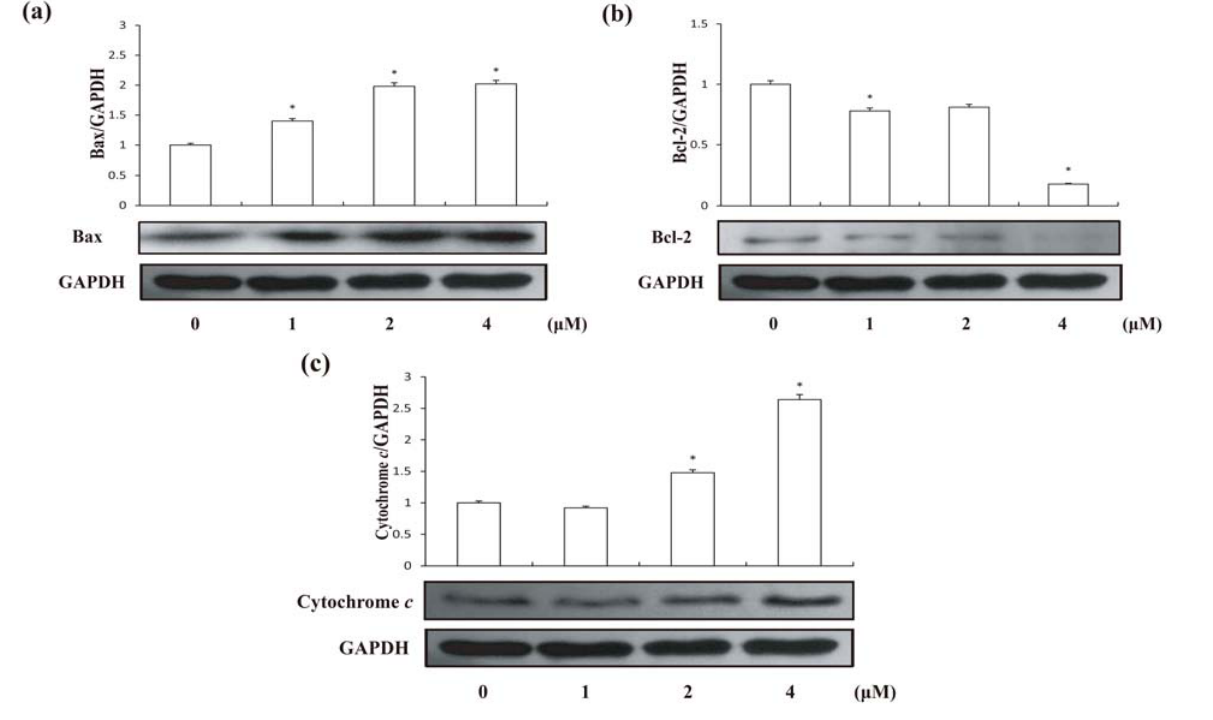
Figure 5. Expression levels of Bax and Bcl-2 in HCT-8 cells treated by compound 1 at different concentrations for 24 h; ( a ) Bax expression; ( b ) Bcl-2 expression; and ( c ) Cytosolic cytochrome c . Results are expressed as mean ± SD (n = 3). * p < 0.05, significantly different from the untreated